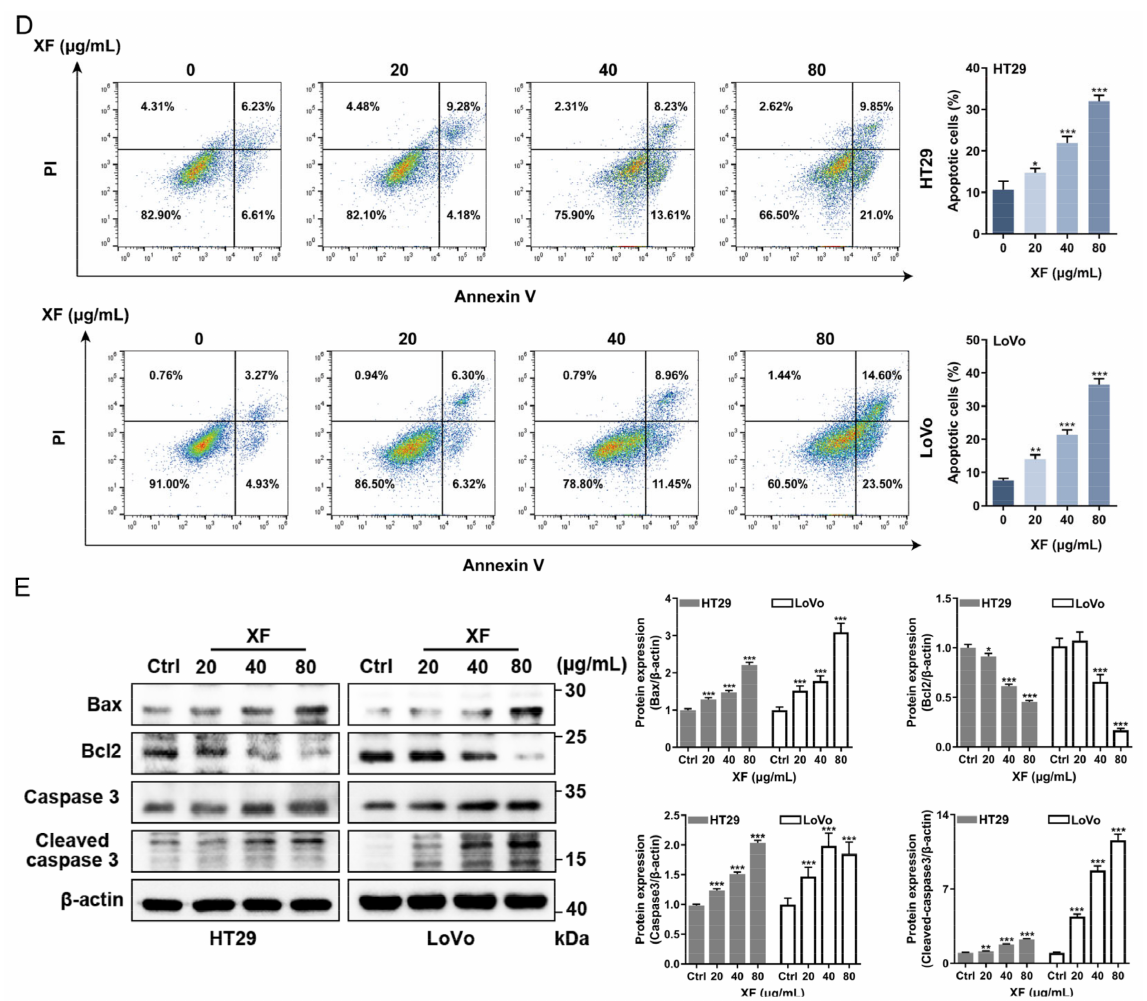
Figure 3. Effect of XF on HT29 and LoVo cells. ( A , a ) Effect of XF on HT29 and LoVo cells proliferation; ( B , b ) Effect of XF on HT29 and LoVo cells migration; ( C , c ) Effect of XF on HT29 and LoVo cells invasion; ( D ) Representative results of Annexin V-FITC/PI staining of HT29 and LoVo cells treated with XF for 24 h; ( E ) Apoptosis related protein expressions of Bax, Bcl2, caspase 3, and cleaved-caspase 3 in XF-treated CRC cells. Data are presented as the means ± SEM, n = 3. * p < 0.05, ** p <